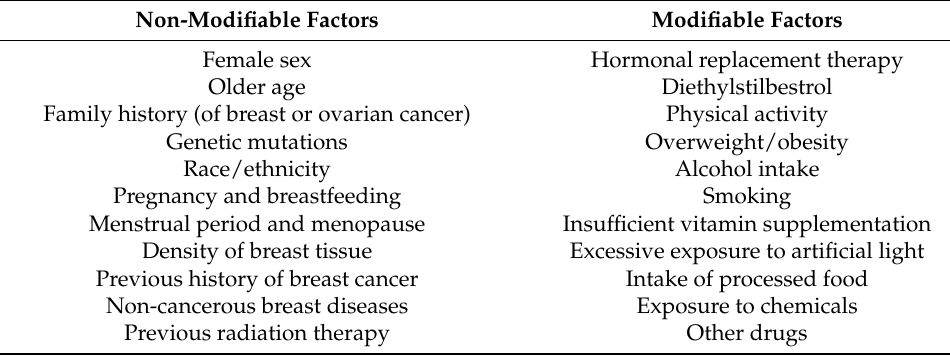
Table 1. Modifiable and non-modifiable risk factors of breast